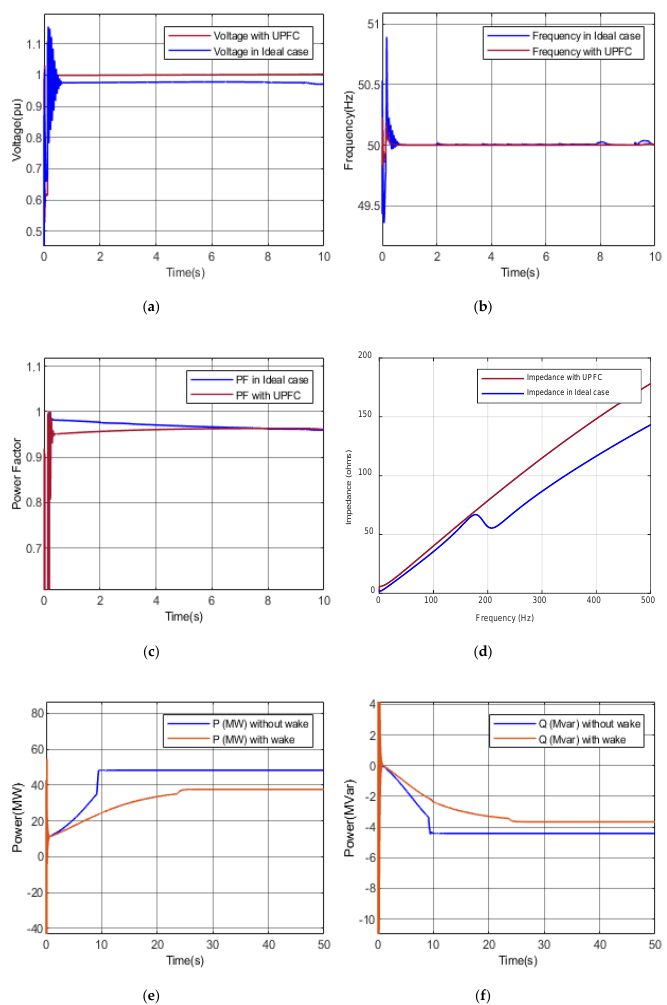
Figure 13. Case-2, Scenario 10: ( a ) Voltage (V) at PCC; ( b ) frequency (F) at PCC; ( c ) PF at PCC; ( d ) impedance (Z) vs. F; ( e ) P-trend; and ( f )